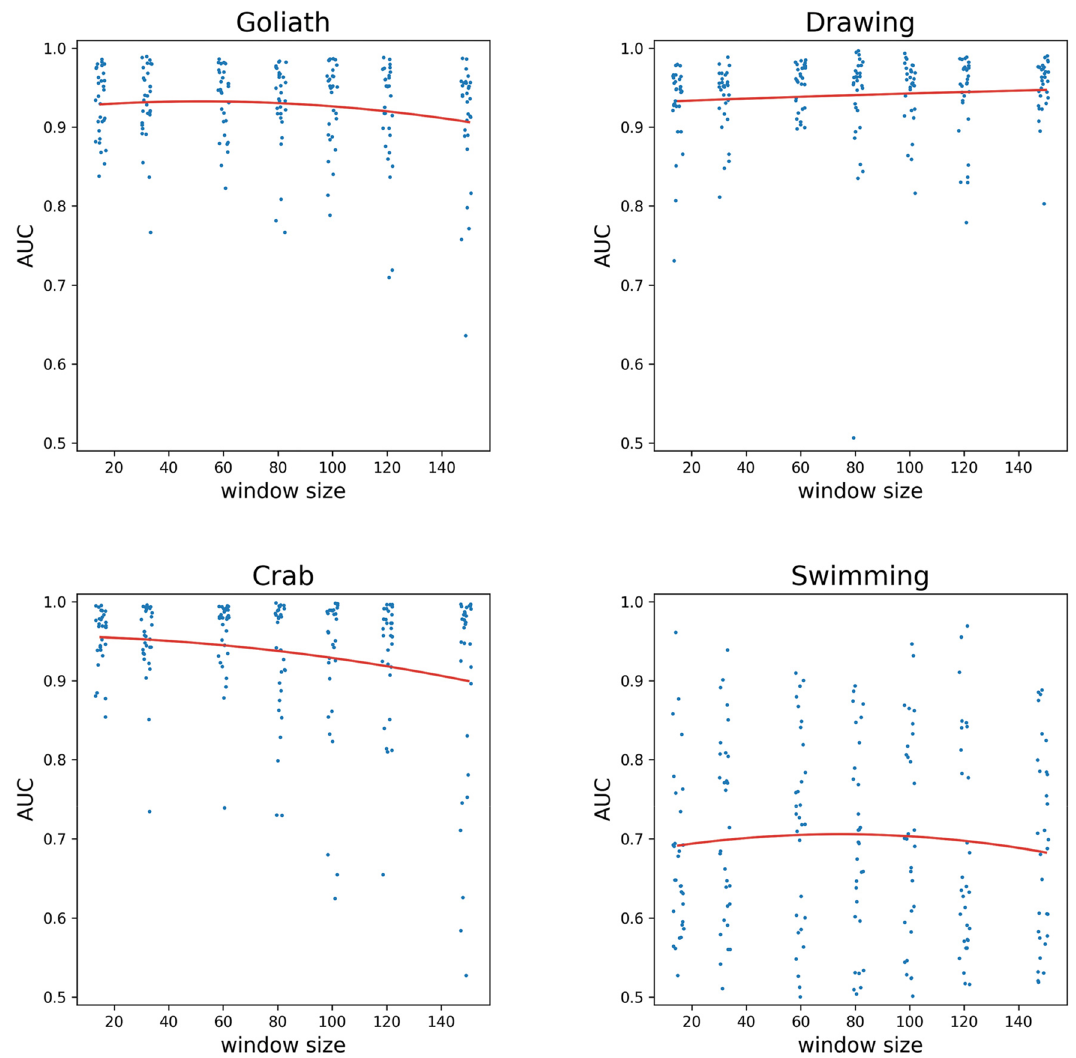
Figure 2. Playful activities with the highest AUC values, AUC values as a function of the window size. Quadratic curves fitted (Goliath: adj. R 2 = 0.007, Drawing: adj. R 2 = 0.074, Crab: adj. R 2 = 0.084, Swimming: adj. R 2 = 0.026). A small random jitter was added to the window sizes for better